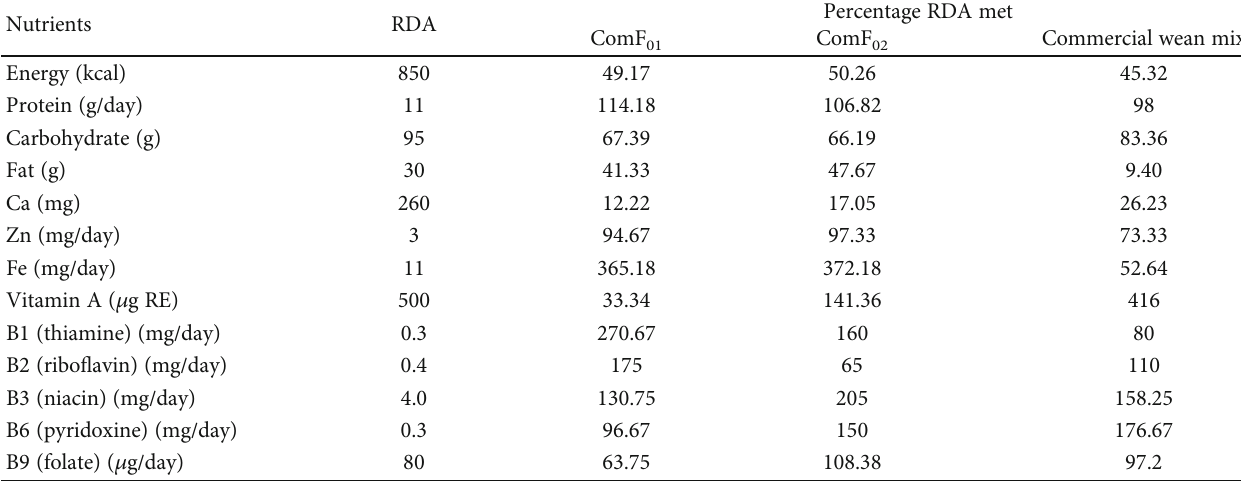
Table 4: Percentage contribution of macro- and micronutrients provided by complementary foods and commercial wean mix meeting RDA for 6-12 months.